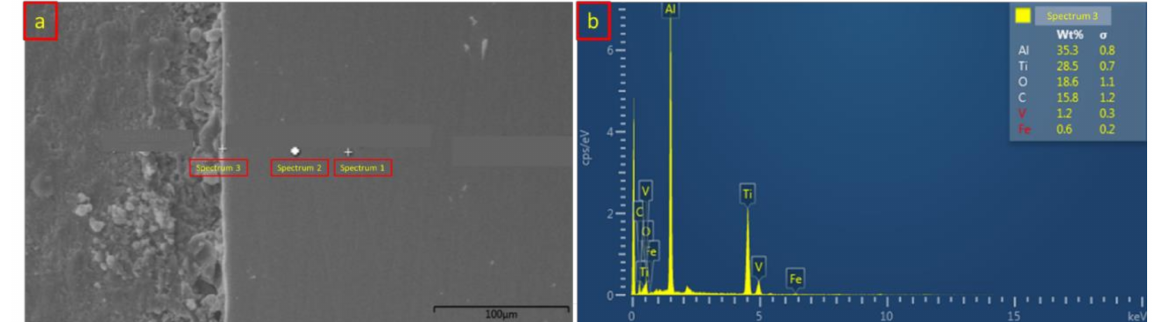
Figure 11. ( a ) Ti/Al spectrum distribution of the EDX analysis from sample 1; ( b ) Ti/Al EDX analysis result on the IMC layer from sample 1.